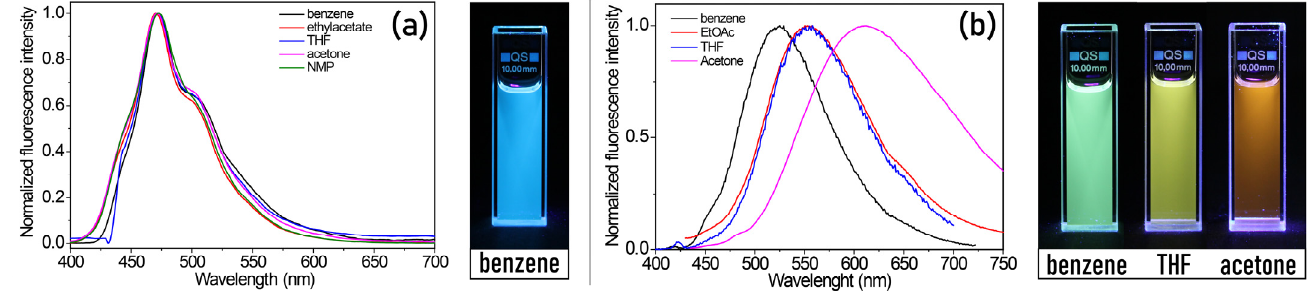
Figure 2. The emission spectra of Phz1 ( a ) and Phz2 ( b ) in various solvents.